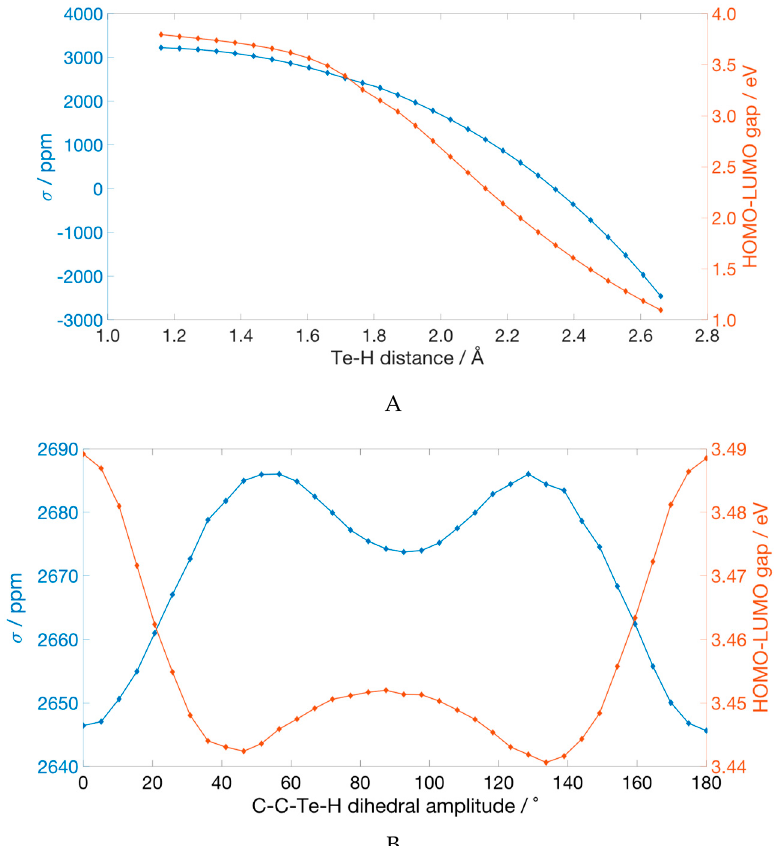
Figure 4. ( A ) Values of the 125 Te isotropic shielding constant and of the HOMO-LUMO gap of PhTeH at different Te–H distances. ( B ) Values of the 125 Te isotropic shielding constant of PhTeH at different values of the C–C–Te–H dihedral angle. Level of theory: ZORA-OPBE/QZ4Pae//ZORA-OPBE/TZ2P.